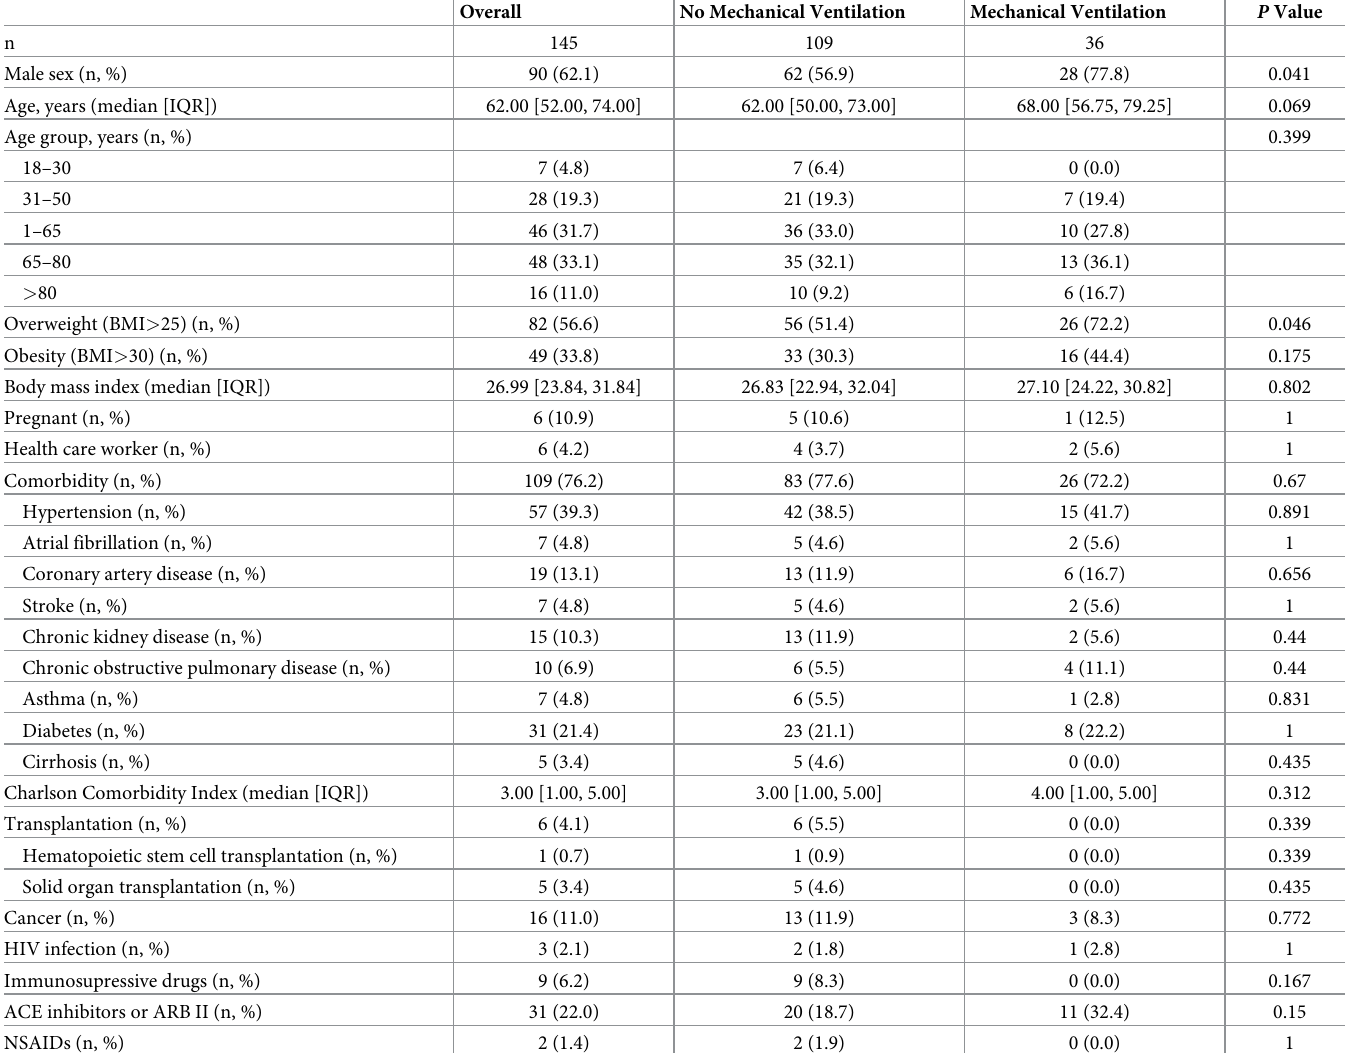
Table 2. Demographics of patients on